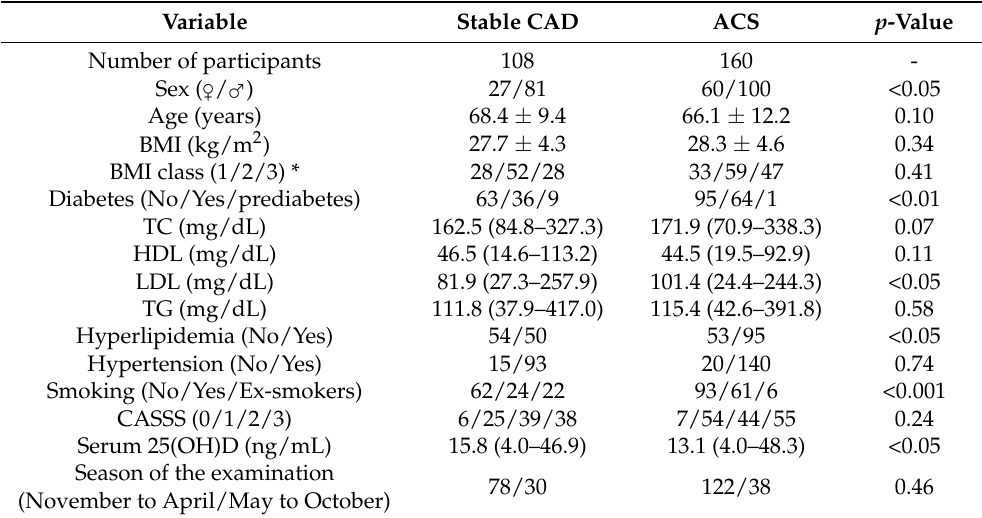
Table 2. Comparison of the obtained parameters between patients with stable coronary artery disease and patients with acute coronary syndrome.